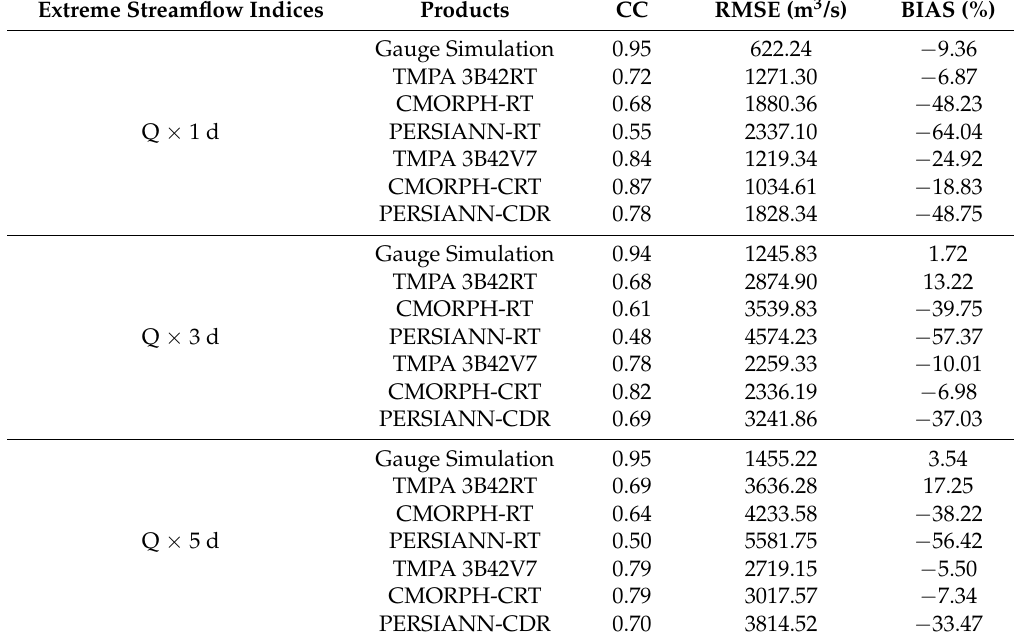
Table 6. Statistical measures of the SPPs simulated annual maximum 1-, 3-, and 5-day streamflow.